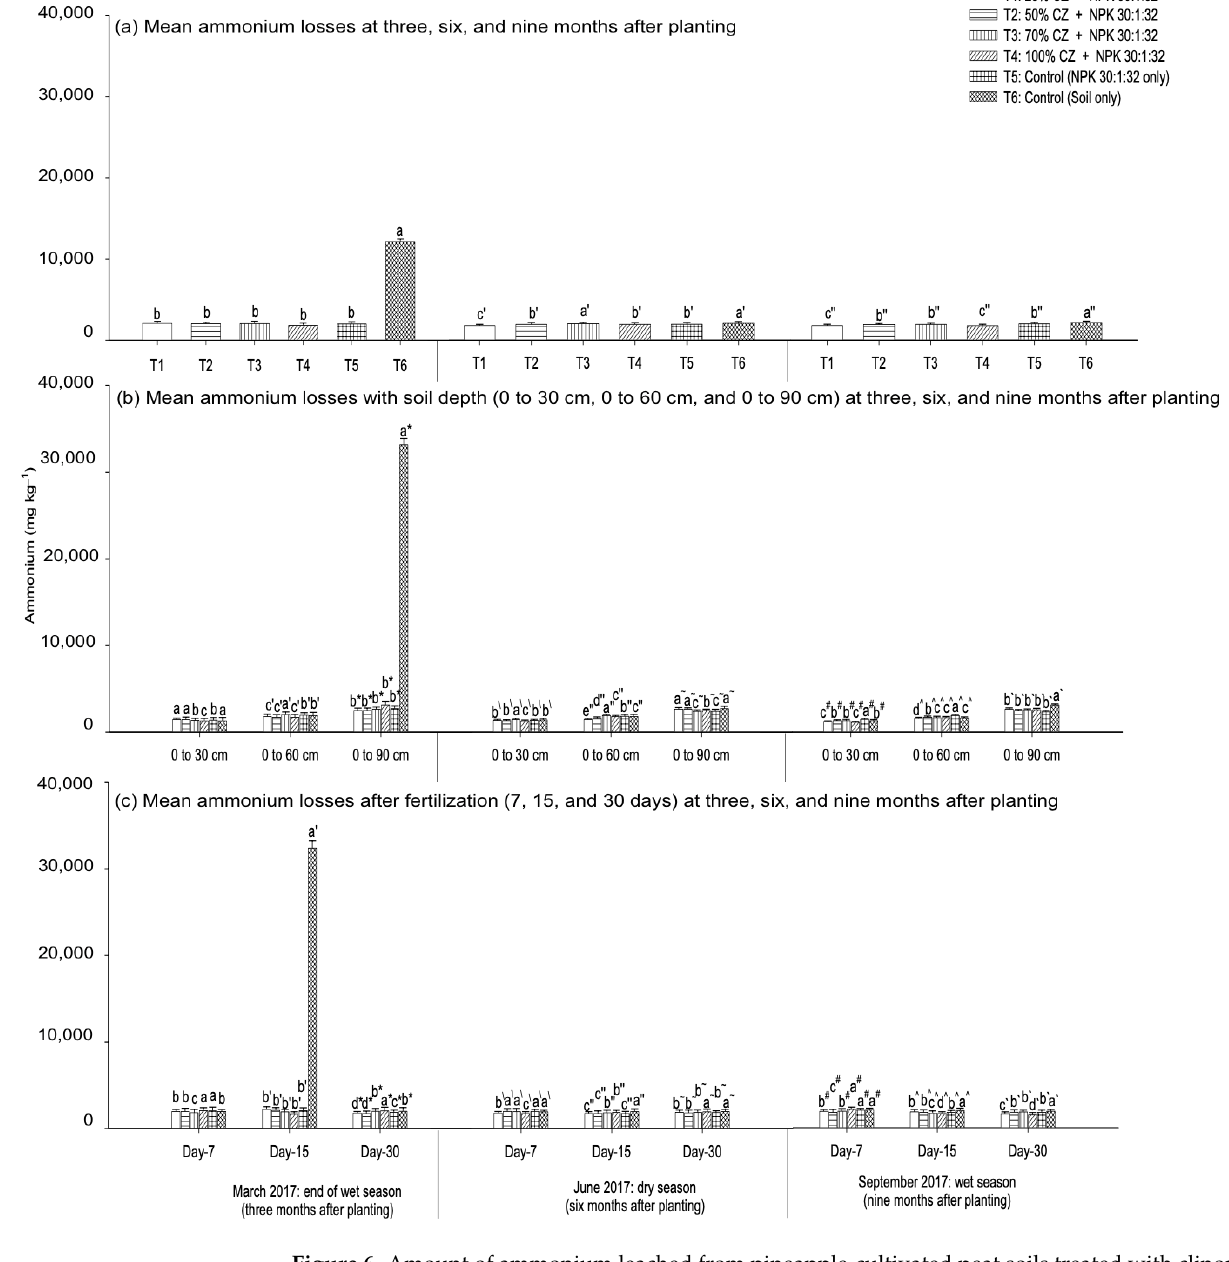
Figure 6. Amount of ammonium leached from pineapple-cultivated peat soils treated with clinoptilolite zeolite at different vegetative stages (three, six, and nine months after planting): ( a ) mean amount of ammonium losses, ( b ) ammonium losses with soil depth (0 cm to 30 cm, 0 cm to 60 cm, and 0 cm to 90 cm), and ( c ) ammonium losses after fertilization (seven, fifteen, and thirty days) throughout the wet (March and September 2017) and dry (June 2017) seasons. Error bars indicate the standard error of the mean (n = 162). Means with different letters are significantly different using Tukey’s test with p ≤ 0.05. CZ: clinoptilolite zeolite. Letters without primes, single primes, and double primes represent mean ammonium losses respectively at three (March 2017), six (June 2017), and nine (September 2017) months after planting. Letters without primes, single primes, and asterisks represent ammonium losses at the end of the wet season (March 2017), letters with backslashes, double primes, and tildes represent the dry season (June 2017), and letters with hashes, carets, and backticks represent the wet season (September 2017).